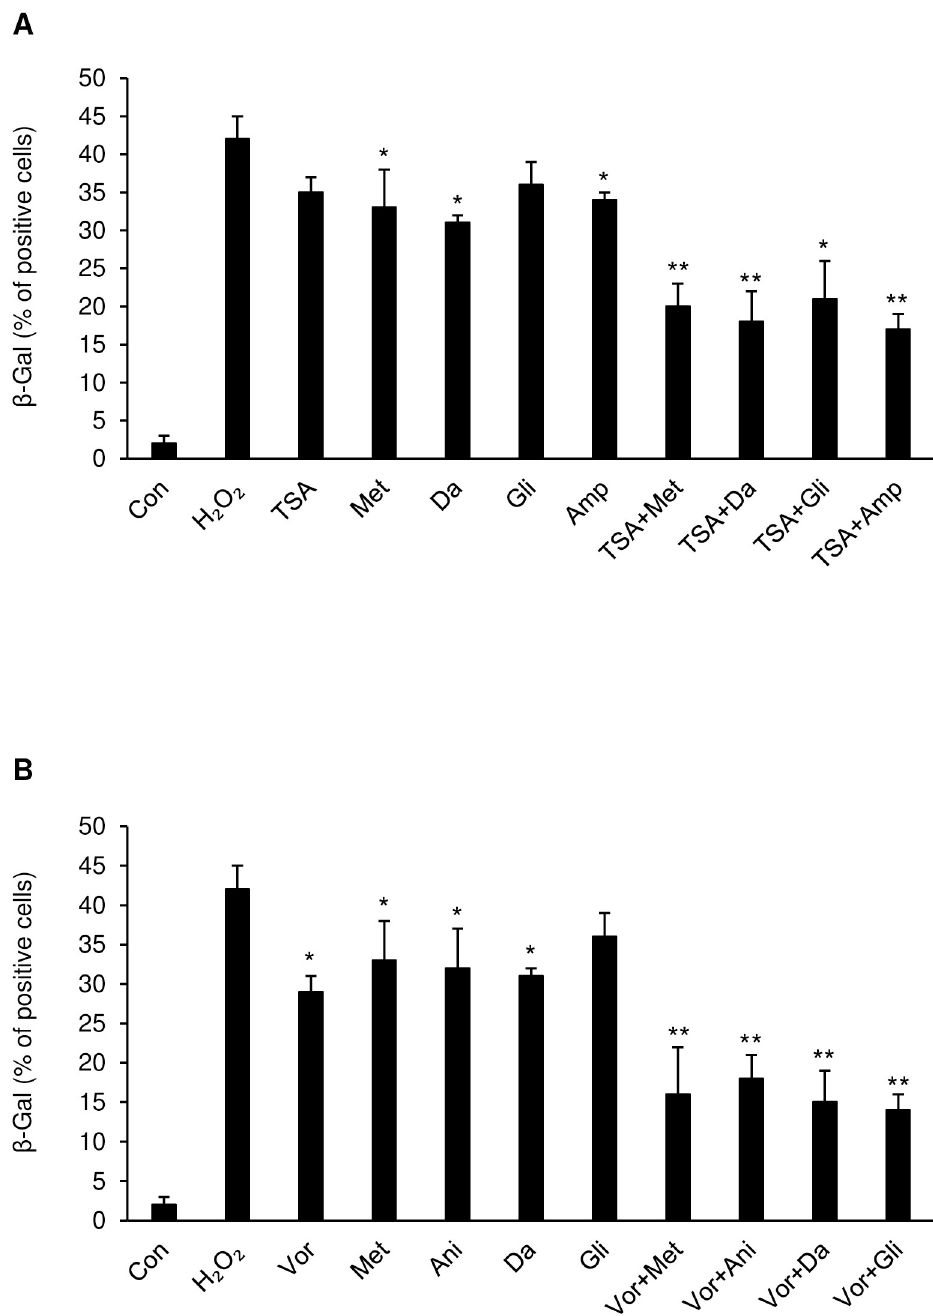
Fig 6. Combinatorial drug pairs decrease cell senescence in HL-60 cells. (A) HL-60 cells were exposed to H 2 O 2 (10 μ M) for 24 h and then treated with trichostatin A, metformin, danazol, glibenclamide, ampyrone, and each prior drug was co-treated with trichostatin A. or (B) with vorinostat, metformin, anisomycin, danazol, glibenclamide and each prior drug with vorinostat for 36 h. Then the cells were incubated with β -galactosidase and stained cells were counted and plotted. � p < .05, �� p < .01 vs H 2 O 2 group.